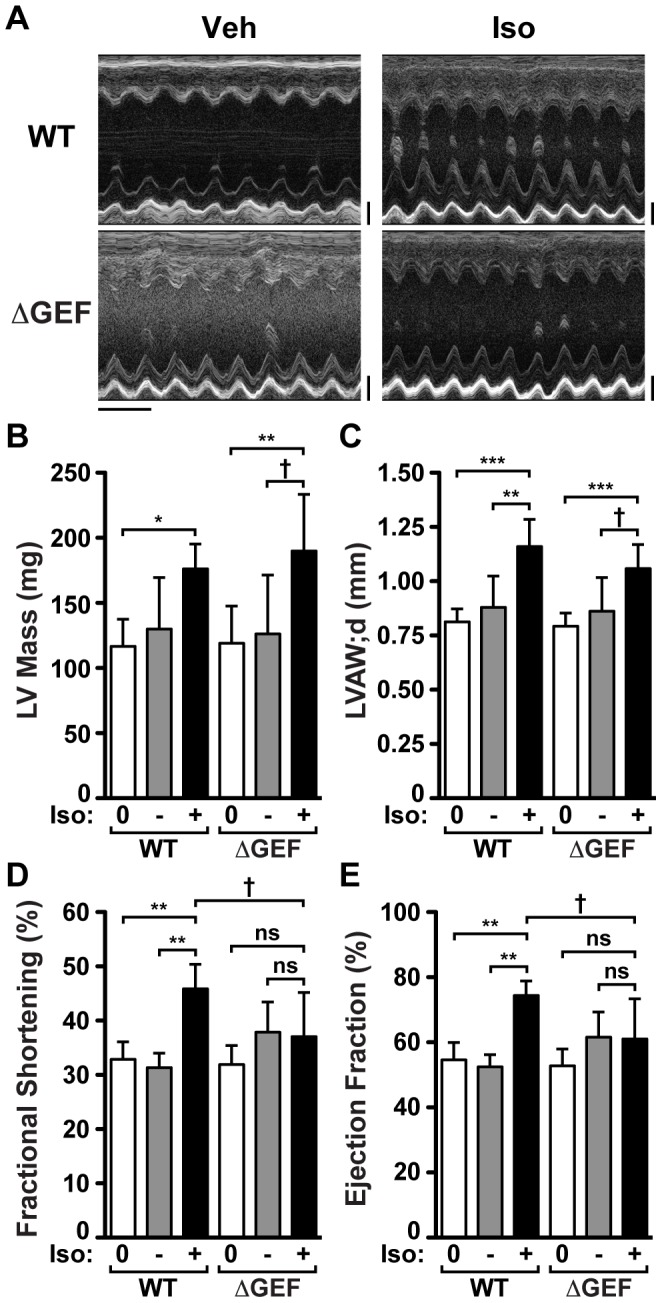
AKAP13-ΔGEF mutant mice undergo cardiac remodeling but have abnormal contractility in response to β-adrenergic-induced hypertrophy.(A) Representative M-Mode echocardiogram images showed a thicker left ventricular wall in wild-type (WT) and AKAP13ΔGEF/ΔGEF (ΔGEF) male mice treated with isoproterenol (Iso; 60 mg/kg per day for 13 days) than in those treated with PBS vehicle (Veh). Iso treatment increased the magnitude of contraction in WT mice but not in ΔGEF mice. The horizontal black scale bar is 200 ms; the vertical black scale bars are 1 mm. (B–E) Quantification of echocardiography data for left ventricle structural and functional changes in response to Iso treatment. Echocardiograms were recorded the day before mini-osmotic pumps were implanted for baseline levels (0) and after 13 days of Iso (+) or Veh (-) treatment. (B) Both WT and ΔGEF mice increased left ventricular (LV) mass to the same level with Iso treatment. (C) LV anterior wall thickness at diastole (LVAW;d) was increased to the same level in both WT and ΔGEF mice treated with Iso. (D) The percent of fractional shortening (FS) was greater in wild-type mice treated with Iso compared to baseline or Veh treatment. FS was not different in ΔGEF mice treated with Iso compared to baseline or Veh controls. However, ΔGEF mice treated with Iso tended to have reduced FS compared to wild-type controls. (E) The percent ejection fraction (EF) also was greater in wild-type mice treated with Iso than baseline or Veh treatment. Again, EF was not different in ΔGEF treated with Iso compared to baseline or Veh controls, but tended to be less than wild-type controls. The means and standard deviations are graphed in B–E for seven WT and nine ΔGEF mice at baseline (0), three WT and three ΔGEF mice with Veh treatment, and four WT and six ΔGEF mice with Iso treatment. One-way ANOVA and Bonferroni’s multiple comparison tests were conducted (Prism 5; GraphPad). †, p<0.10; *, p<0.05; **, p<0.01; ***, p<0.001.